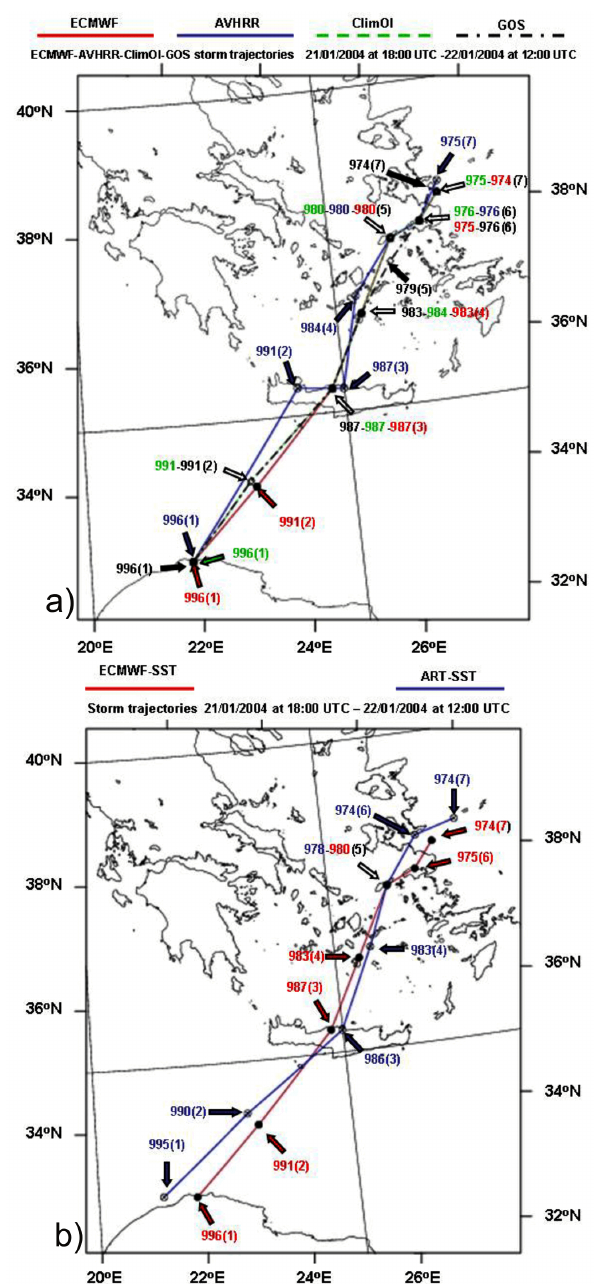
Fig. 5. Simulated storm tracks of the experiments (a) ECMWF- SST, AVHRR-SST, ClimOI-SST and GOS-SST, and (b) ECMWF- SST and ART-SST valid from 18:00 UTC 21 January 2004 to 12:00 UTC 22 January 2004 with 3-h time increment (7 time spots). The labels indicate the central mean sea level pressure (hPa) of the sys- tem and the values in the parentheses denote the relevant time